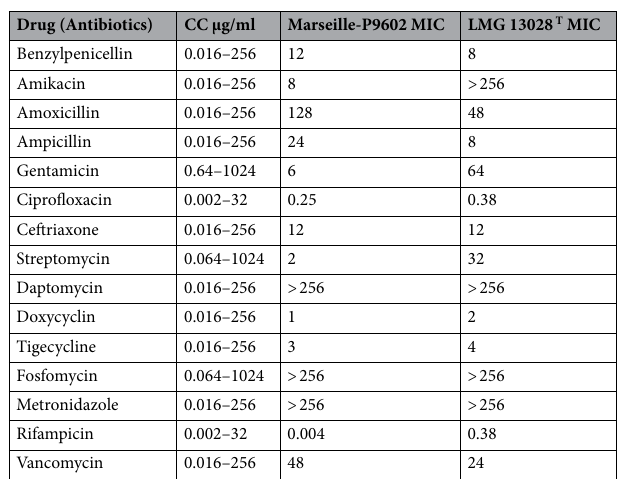
Table 6. Antimicrobial susceptibility and MIC values of Marseille-P9602 and Chryseobacterium scophthalmum LMG 13028 T strains. CC Tested range of drug concentration in µg/ml (microgram/milliliter). MIC Minimum inhibition of concentration in µg/ml (microgram/milliliter).